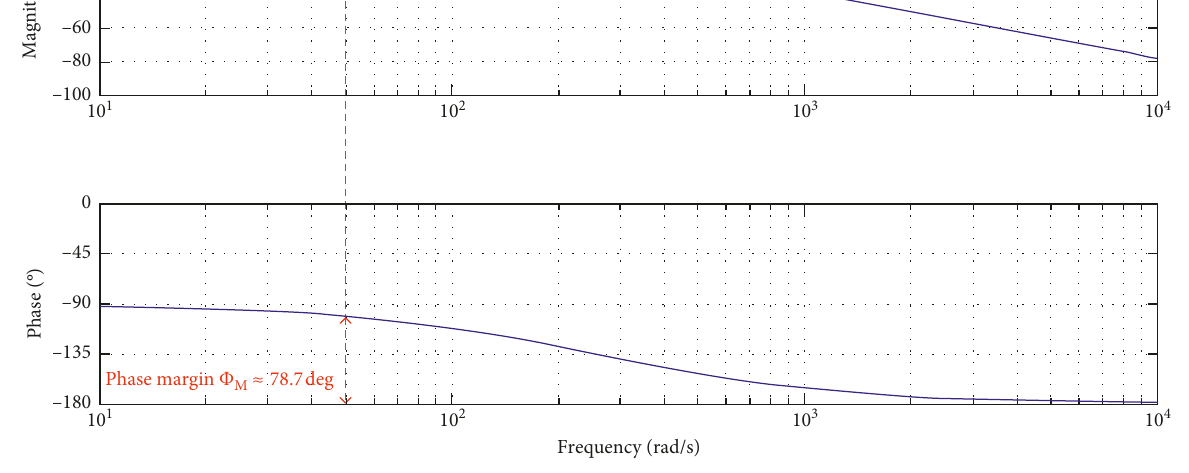
Figure 8: Bode plot of g